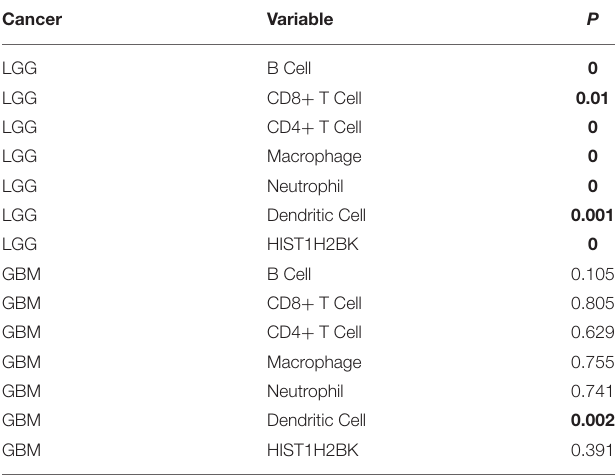
TABLE 2 | Univariate analysis of the correlation among HIST1H2BK expression, immune infiltration, and OS in patients with glioma.